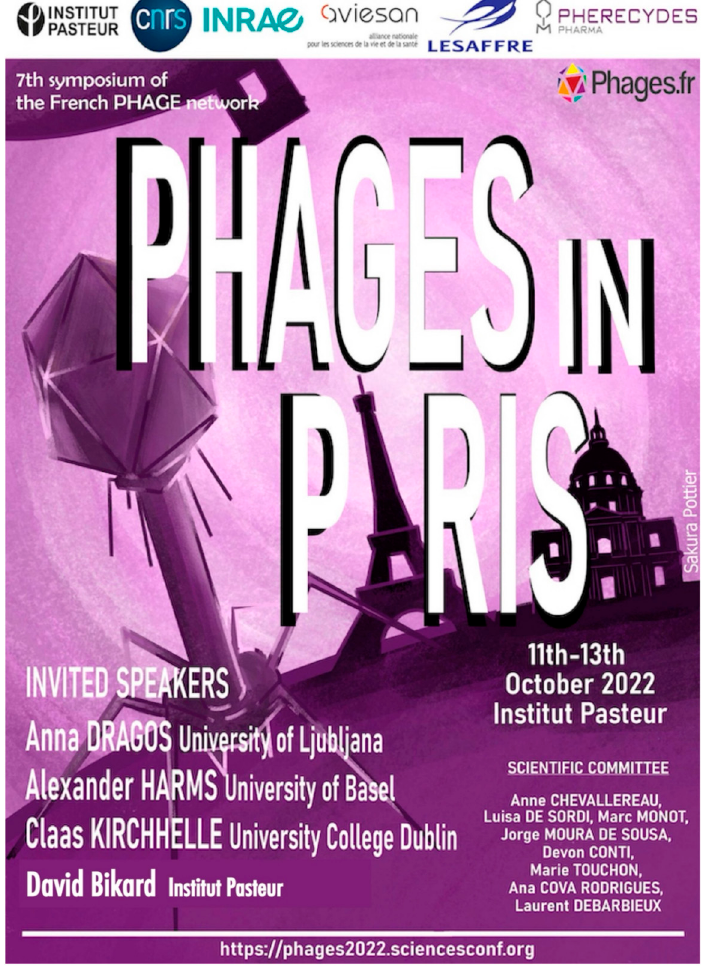
Figure 1. Poster of the conference “Phages in Paris.”